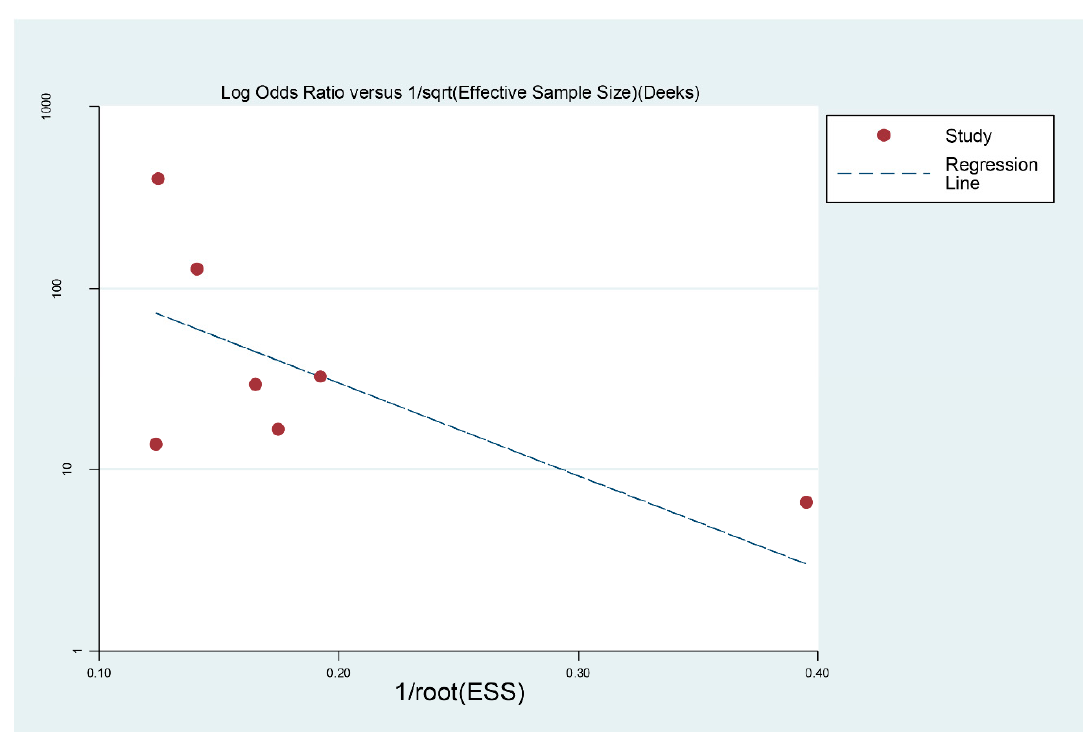
Figure 5. Deeks funnel plot to determine the publication bias of included articles.